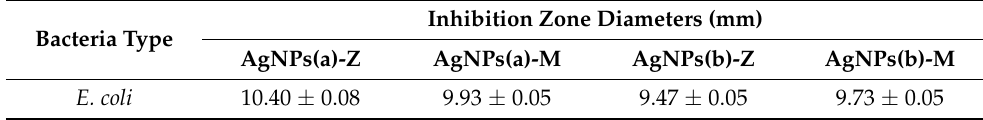
Figure 4. Inhibition zone of ( a ) additives with ex situ synthesized AgNP and ( b ) additives with in situ synthesized AgNP: 1. AgNPs(a)-Z; 2. AgNPs(a)-M; 3. AgNPs(b)-Z; 4. AgNPs(b)-M; and 5. Con- trol.